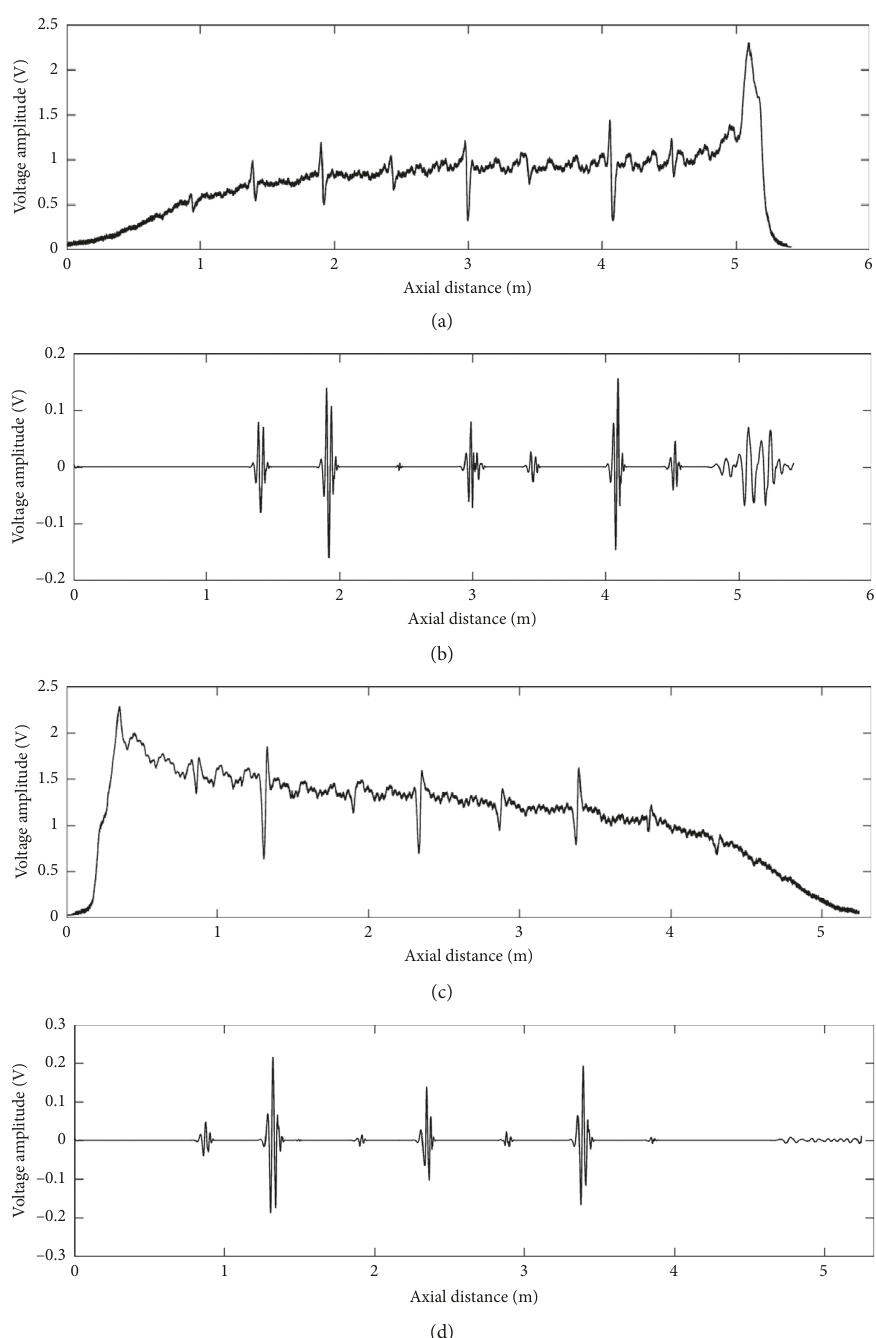
Figure 6: (a, c) Single-channel raw data. (b, d) Data after